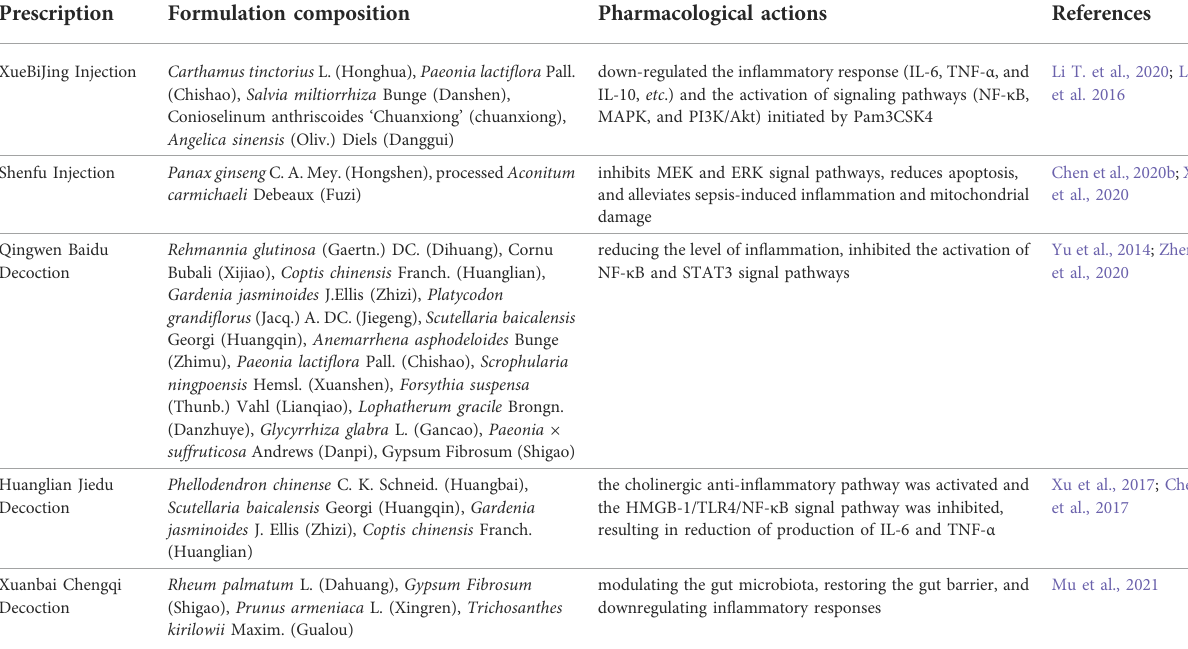
TABLE 1 Formulation composition and pharmacological actions of representative